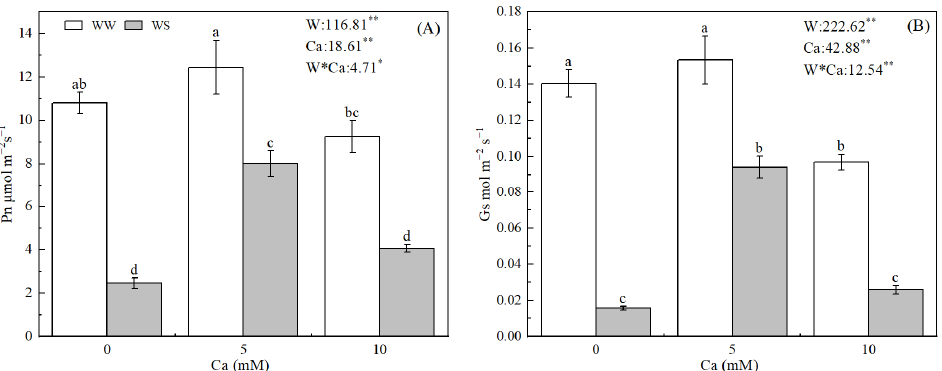
Figure 2. Photosynthetic rate (Pn, A ) and stomatal conductance (Gs, B ) of Pinus sylvestris var . mongolica exposed to well water (WW), water stress (WS), and different calcium (Ca) concentrations. Fluorescence transient curves for all samples displayed feature sequences for OJIP steps, and K was visible in all treatments in the OJIP transient. The O-K and K-J phases of the fluorescence transient were no significant differences among all treatments. While the variable fluorescence amplitude of J-I and I-P phases showed obvious differences. Regard- less of the Ca concentrations, water stress led to a considerable decrease in variable fluo- rescence amplitude of J-I and I-P phases (Figure 3A). Under well-watered treatments, the curve for 10 mM Ca 2+ treatment was at the highest and there were no differences between 0 mM Ca 2+ and 5 mM Ca 2+ , with the exception of P-step (Fm). Under water stress treat- ments, the J-I and I-P phase curves decreased with rising Ca concentrations. The first nor- malization of chlorophyll a fluorescence (Ft/Fo) was performed at Fo (Figure 3B) and O, K, J, I, and P steps were also present. Water stress decreased the variable fluorescence amplitude of J-I and I-P phases, and exogenous calcium caused a decrease under water stress compared with 0 mM Ca 2+ . Figure 3. Chlorophyll a fluorescence OJIP transient curves of Pinus sylvestris var . mongolica exposed to well water, water stress, and different calcium concentrations, descripting the fluorescence rise from Fo (O) to Fm (P). Chl a fluorescence transient curves exhibiting fluorescence intensity (a.u.: arbitrary unit); ( A ) normalization at Fo (Ft/Fo); ( B ) CK: Control; DC: drought; Ca5: 5 mM Ca 2+ ; DC-Ca5: combined drought and 5 mM Ca 2+ ; Ca10: 10 mM Ca 2+ ; DC-Ca10: combined drought and 10 mM Ca 2+